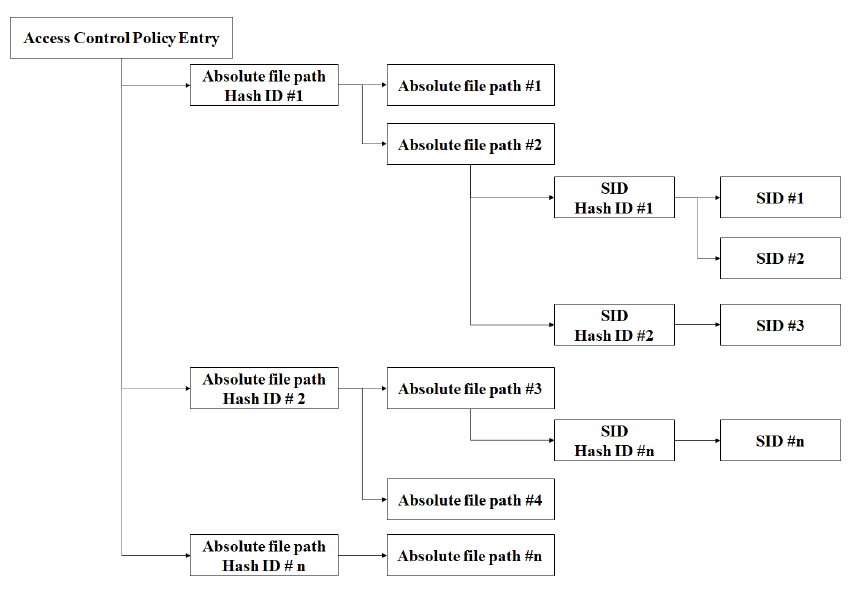
Figure 9. Structure of the Policy List .